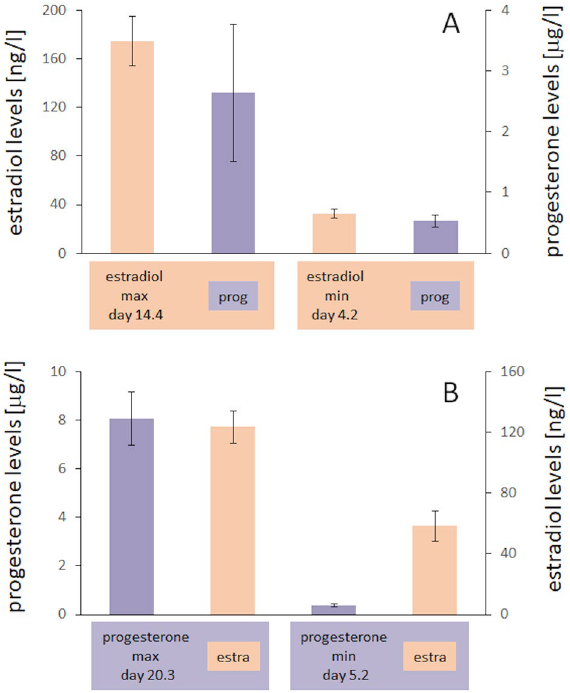
Figure 8. Relation between estradiol and progesterone levels. Hormone levels for estradiol and progesterone at lowest and highest levels for estradiol ( A ) and for progesterone ( B ). estra estradiol, prog progesterone. Data are represented as mean ±